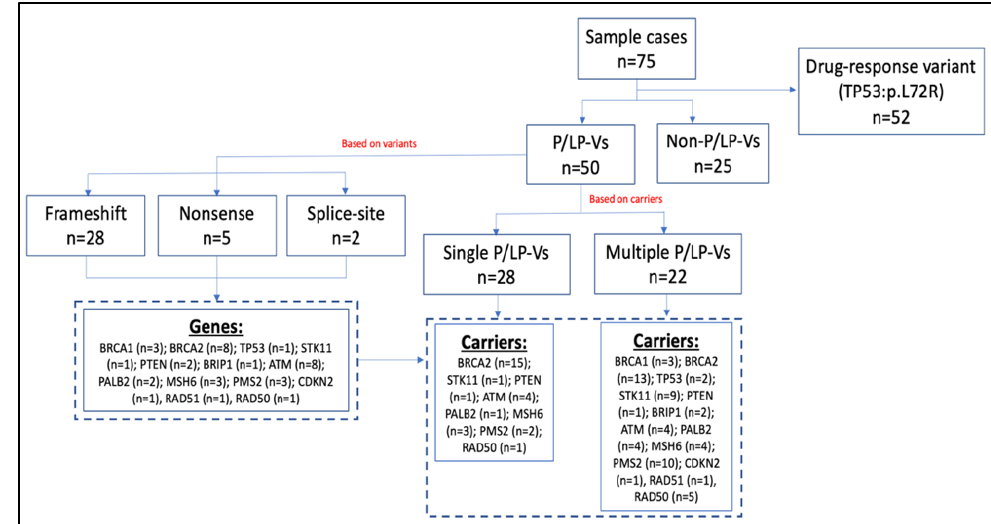
Figure 1. Flow chart of the germline variants characteristics. From Figure 1, we could identify 50 patients (67%) that carried P/LP-Vs. Based on the Table 2. Pathogenic and likely pathogenic germline variants carriers, there were 28 (56%) of P/LP-Vs patients carried single P/LP-Vs and the remaining 22 patients (44%) carried multiple P/LP-Vs (Table S2). Based on the gene variants, we found 35 P/LP-Vs (Table 2) that contained 28 frameshift, 5 nonsense, and 2 splice-site var- iants. Table 2. Pathogenic and likely pathogenic germline variants (P/LP-Vs).